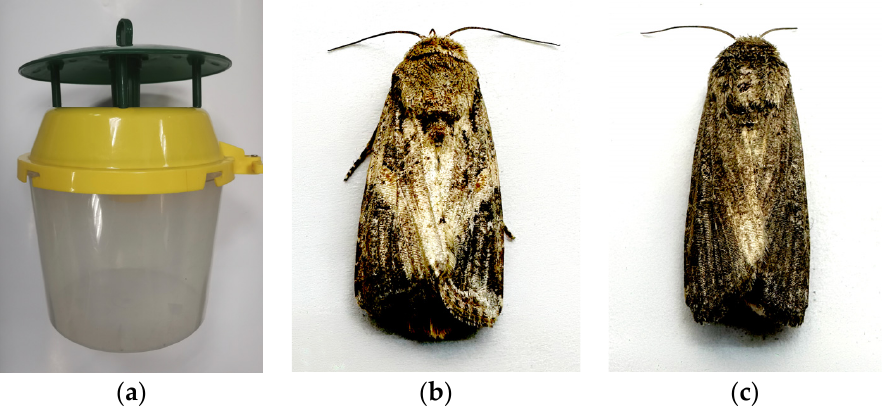
Figure 1. Adults of S. frugiperda and the traditional monitoring trap. ( a ) The traditional unitrap. ( b ) Male moth of S. frugiperda. ( c ) Female moth of S. frugiperda